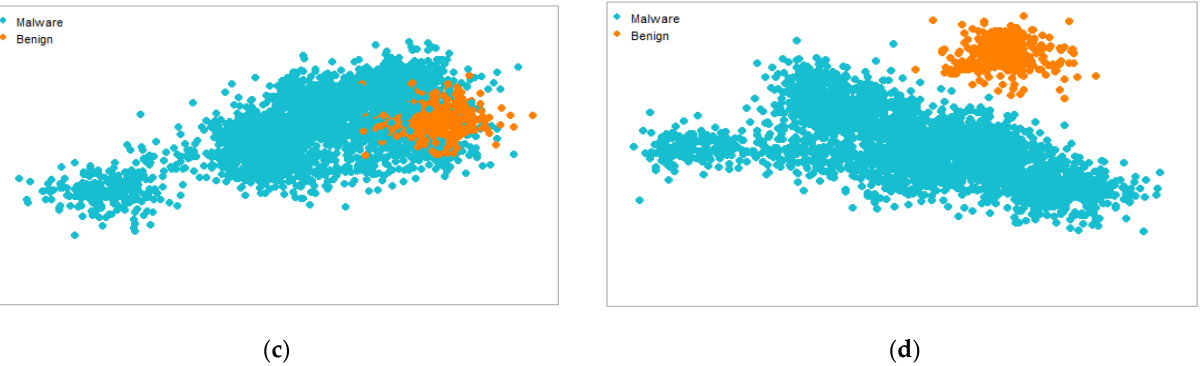
Figure 12. t-SNE visualization for fused features using minimum (30 and 35) and optimal (50 and 70) perplexity values. ( a ) Perplexity, 30; ( b ) perplexity, 50; ( c ) perplexity, 35; ( d ) perplexity, 70.